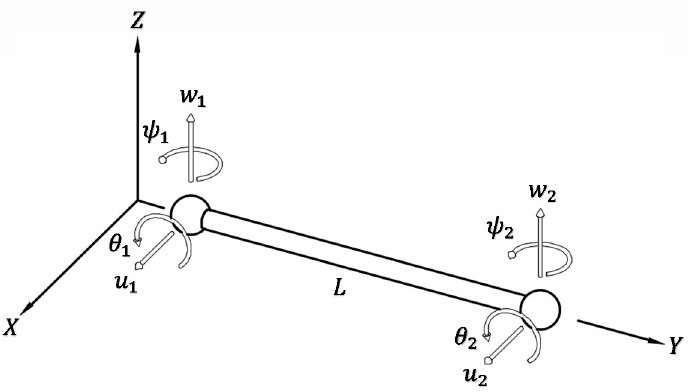
Figure 1. Beam-like finite element for the modelling of the rotor-bearing shaft.